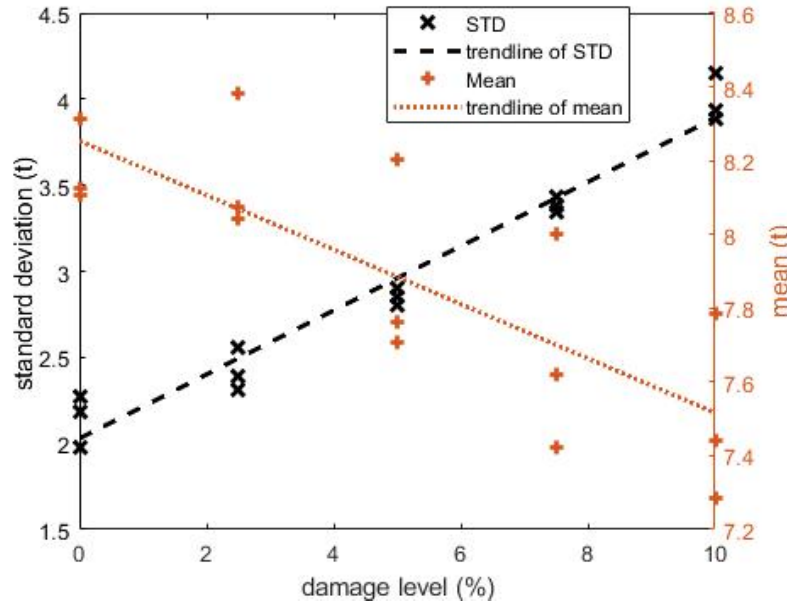
Figure 10. Statistics of 15 batches of 500 vehicles, with simulated errors . The results for the standard deviations are much more repeatable—in this case, the coefficient of determination (R 2 ) of the trendline (linear regression) is 0.96. The variability between batches is considerably less and, for all permutations, the standard deviation of GVW increases with increasing damage. Further, the errors in velocity do not significantly affect the standard deviations for the healthy bridge—compare inferred results of 2.18 t, 1.98 t, and 2.27 t with results for perfect velocities of 2.13 t, 1.90 t, and 2.00 t, respectively. 5. Conclusions This paper presents a newly developed acceleration-based MFI (A-MFI) algorithm, that reformulates existing MFI theory to allow, for the first time, directly measured accel- eration data to be used (refer to Equations (19) and (20)). This reformulation of the under- lying MFI equations allows the new A-MFI algorithm to be directly applied to acceleration data, which is damage sensitive. The accuracy of the inferred axle forces and vehicle weights using A-MFI is reasonable in ideal conditions but is found to be quite sensitive to several sources of error, particularly the accuracy of the vehicle velocity data used. Con- sequently, the statistics of the inferred weight are not accurate. However, the statistics are consistent, and the standard deviation of inferred gross vehicle weight is shown to corre- late well with the stiffness reduction (damage level) of the bridge, even for relatively low levels of global damage.